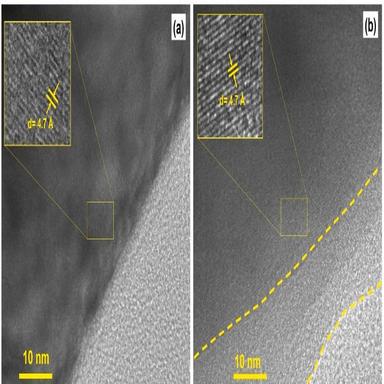
HRTEM images of (a) NCM and (b) Si-20 %.